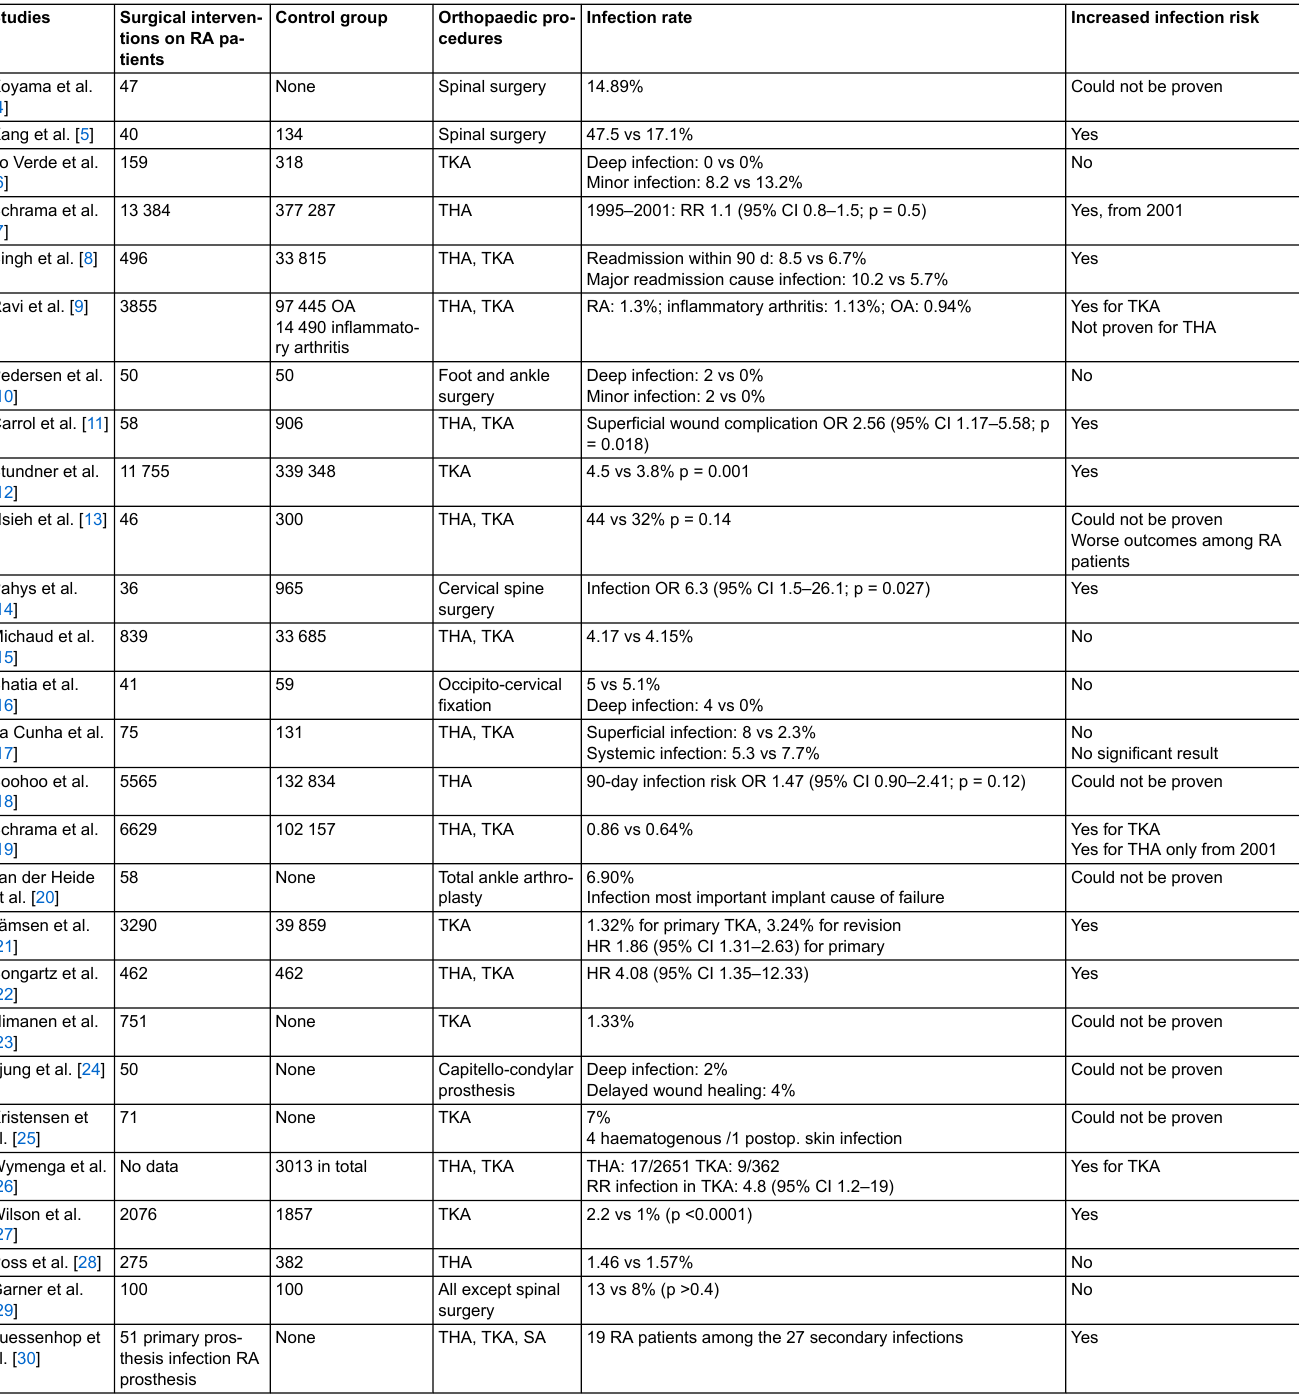
Table 1: Rheumatoid arthritis as a risk factor for postoperative infection. Studies Surgical interven- tions on RA pa-